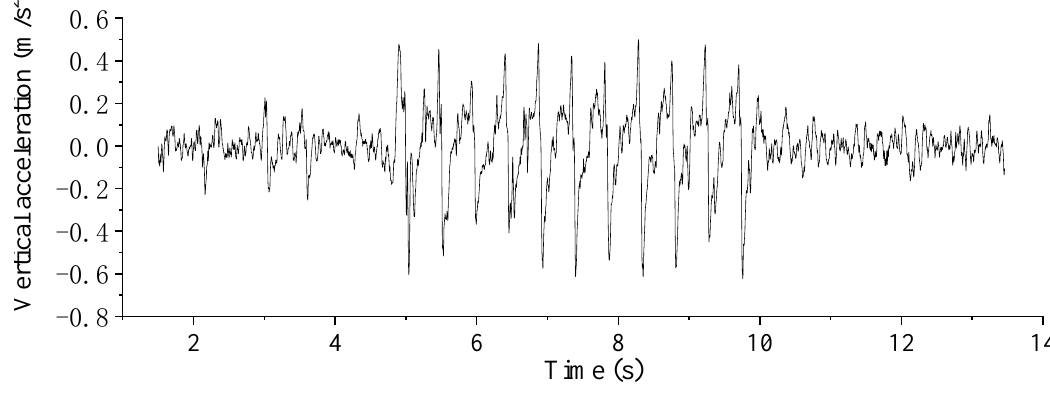
Figure 15. Time history curve of vertical acceleration of car body.